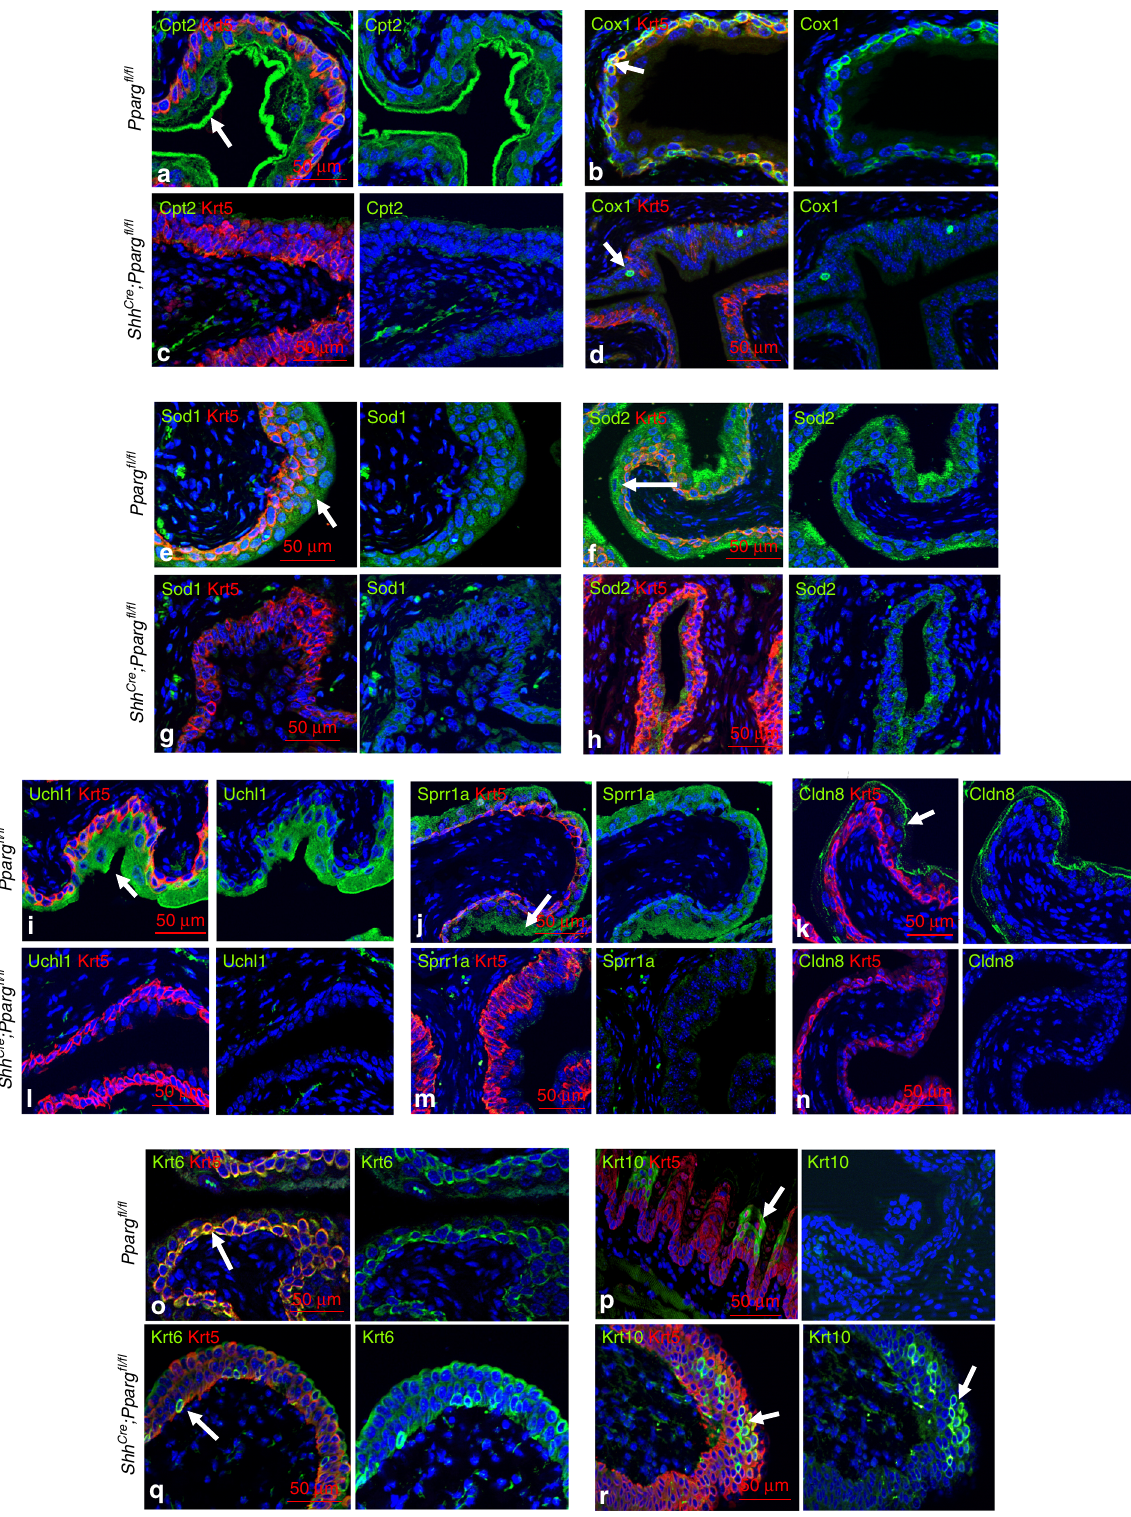
Shh Cre ;Pparg fl / fl mice, including an expanded K14-basal popula- tion and up-regulation of Krt10 (Fig. 8f, g, h, i). Consistent with these observations, RNA-Seq analysis of urothelium from mutants and controls revealed up-regulation of squamous mar- kers (Fig. 8k), and over-representation analysis revealed altera- tions in many of the same pathways as those observed in Shh Cre